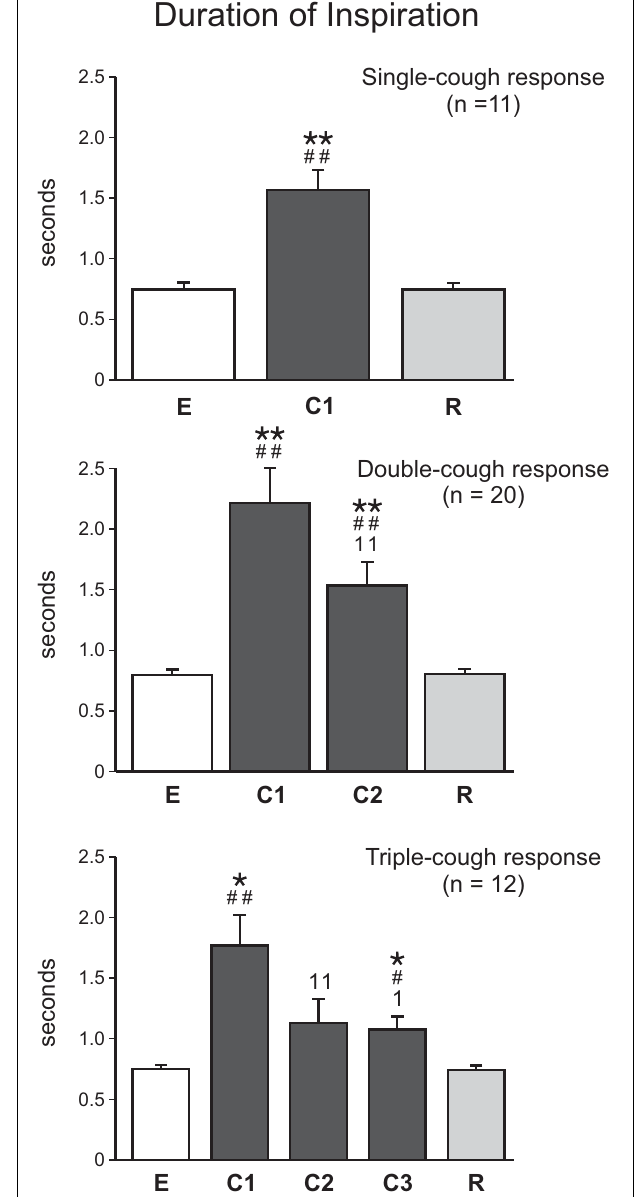
FIGURE 6 |Average inspiratory duration (s) during single-, double-, and triple-cough episodes (top, middle, and bottom panels, respectively). Values for a given cough cycle (e.g., C1) were not different among these three cough response types. *, significantly different from E; #, significantly different from R; 1, significantly different from C1. P -values are indicated by one ( p < 0.02) or two ( p < 0.001) symbols. Error bars indicate the standard error of the